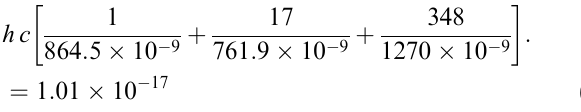
= IO 2 A (cid:133) 0 ; 1 (cid:134) and wavelengths 2